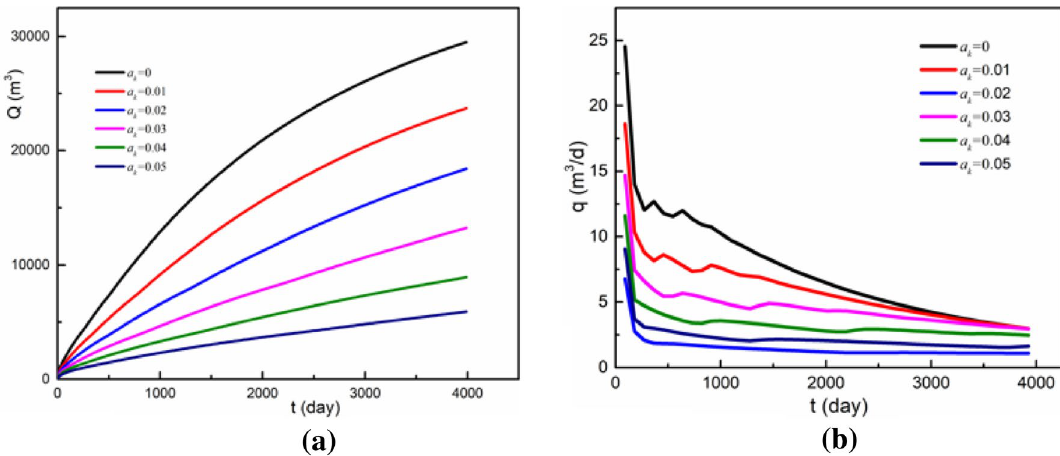
Fig. 5 a Cumulative oil production curve; b daily oil production